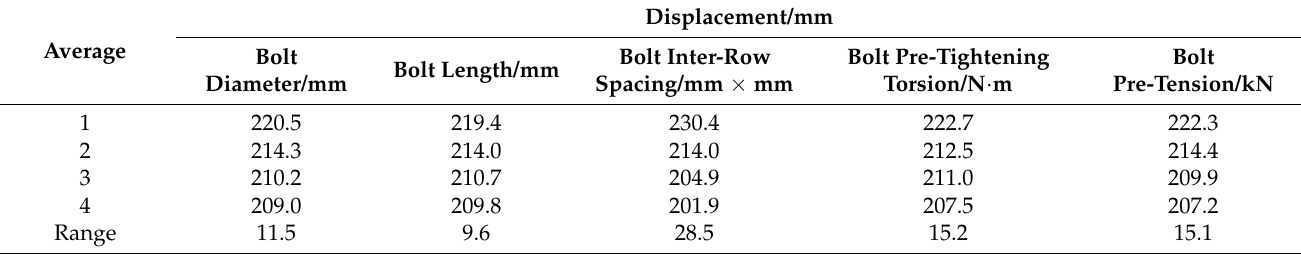
Table 8. Results of visual analysis of approach